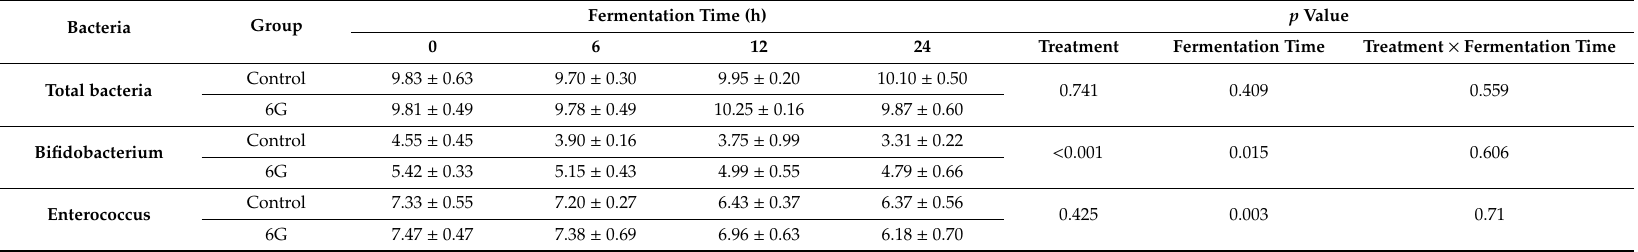
Table 3. Copy numbers (log 10 copies / g) of total bacteria, Bifidobacterium, and Enterococcus in fermentation broths under the normal or 6G treatment at di ff erent fermentation time points. All data are expressed as the mean ±